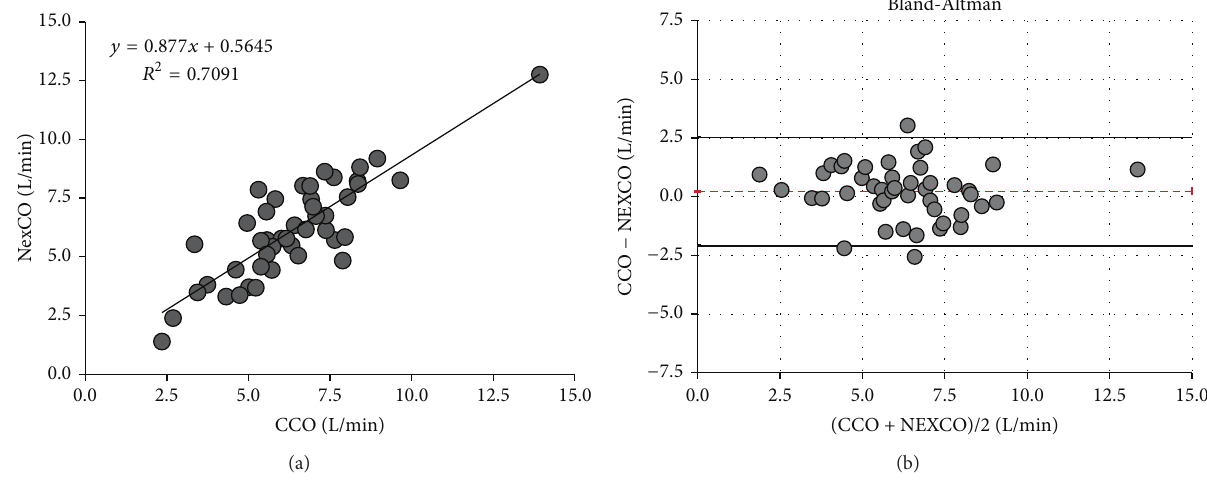
Figure 2: Cardiac output measurements: CCO versus NexCO. Only one average value per patient is plotted. (a) Regression analysis. (b) Bland-Altman analysis. Patient averages with the mean cardiac output ranges ( 𝑥 -axis) and errors ( 𝑦 -axis) during the 8-hour study period. Dotted line indicates bias and solid lines indicate lower and upper limit of agreement. CCO: pulse contour continuous cardiac output NexCO: Nexfin cardiac